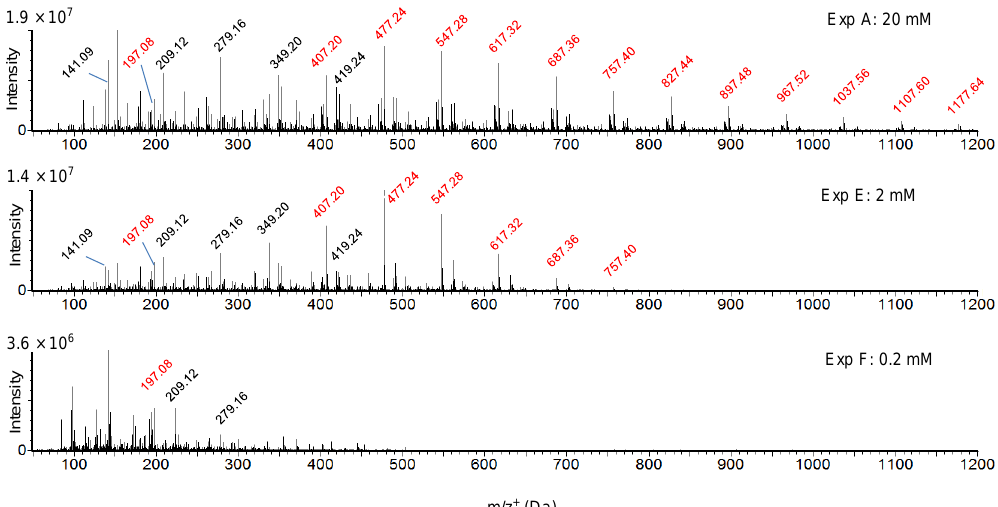
Fig. 7. Mass spectra (obtained using UPLC-ESI-MS, for the retention time range 0–5min, in the positive mode) during experiments A, E and F (i.e., at 25 ◦ C, for different initial MVK concentrations and at different reaction times (corresponding to the maximum oligomers intensity): 5min for 0.2mM; 15min for 2mM and 50min for 20mM. The most intense series (S174) is highlighted in red, as in Fig.